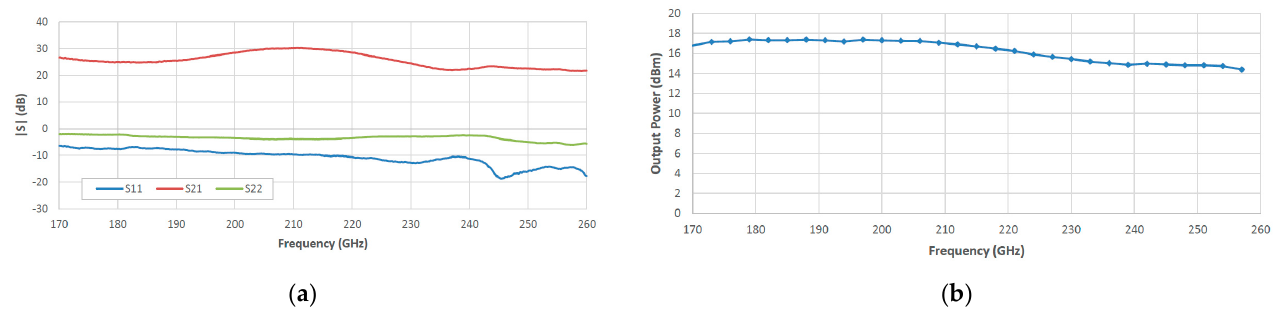
Figure 7. ( a ) Measured S-parameter of the THz power amplifier and ( b ) its saturated output power.